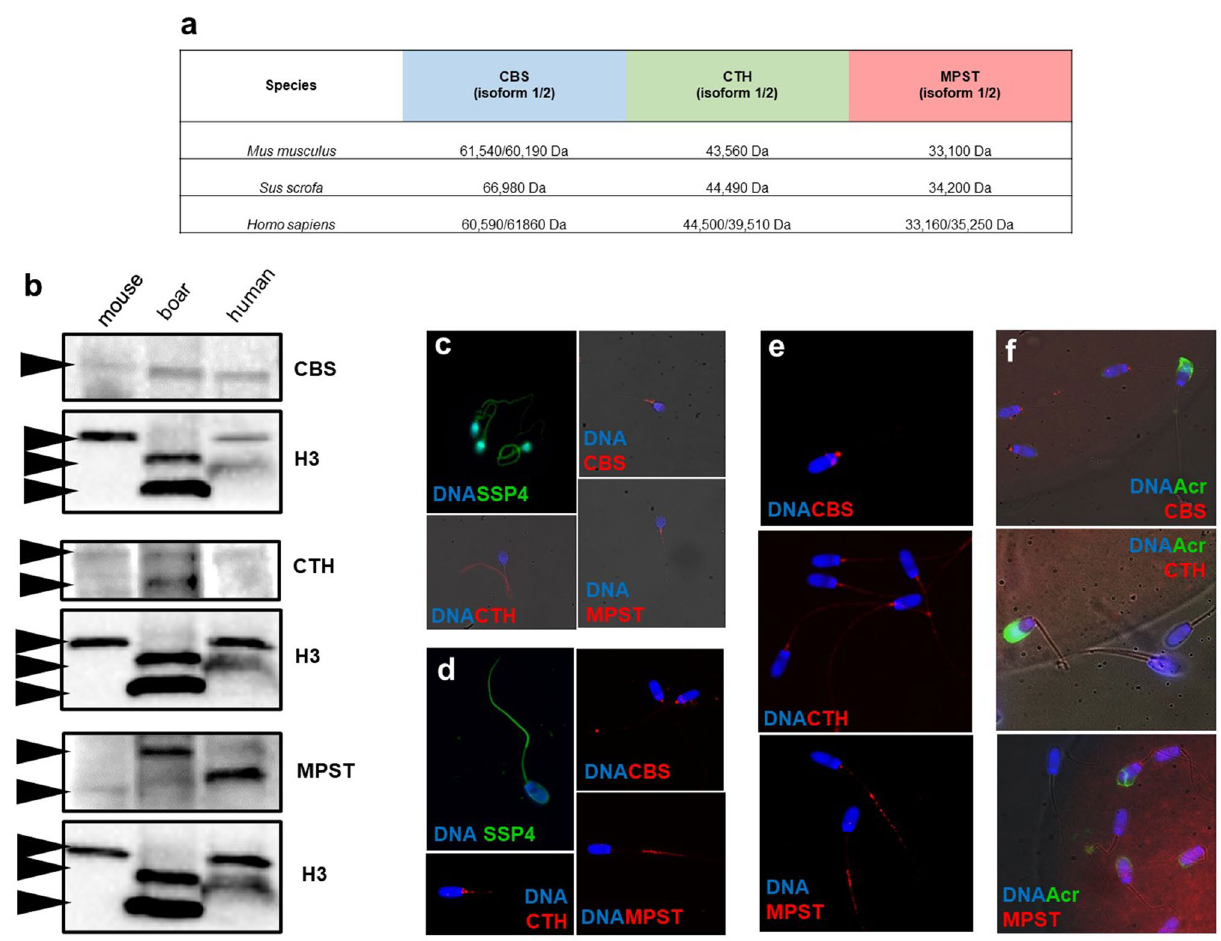
Figure 5. Interspecies production of H 2 S-releasing enzymes and H 2 S. ( a ) Species-specific molecular weight of the individual enzymes. ( b ) Western blot detection of CBS, CTH and MPST in human, boar and mouse spermatozoa. ( c ) Immunocytochemistry of all H 2 S-releasing enzymes and detection of H 2 S production by the SSP4 probe in human and ( d ) boar spermatozoa. ( e ) Decreases in CBS, CTH and MPST signal intensity during the last steps of boar sperm maturation, capacitation and ( f ) acrosomal reaction during sperm- zona pellucida binding. Spermatozoa were emphasized